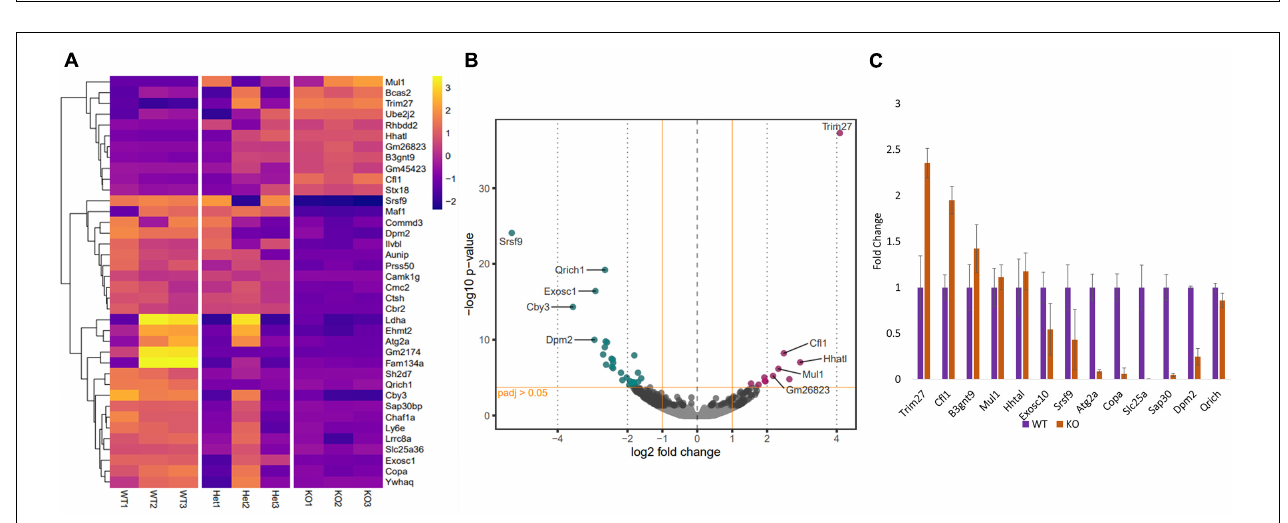
FIGURE 6 | Pfn3 + / + , Pfn3 + / − , and Pfn3 − / − testis sections stained for the cis- (GM130 antibody) and trans- (TGN46 antibody) Golgi compartment (green) and nuclei (DAPI, blue) ( n = 3). (A) WT and (B) heterozygous, and (C) Pfn3 − / − spermatozoa stained for cis -Golgi compartment (asterisks). (D) WT, (E) heterozygous, and (F) Pfn3 − / − spermatozoa stained for trans- Golgi network. Scale bar = 50 µ m.